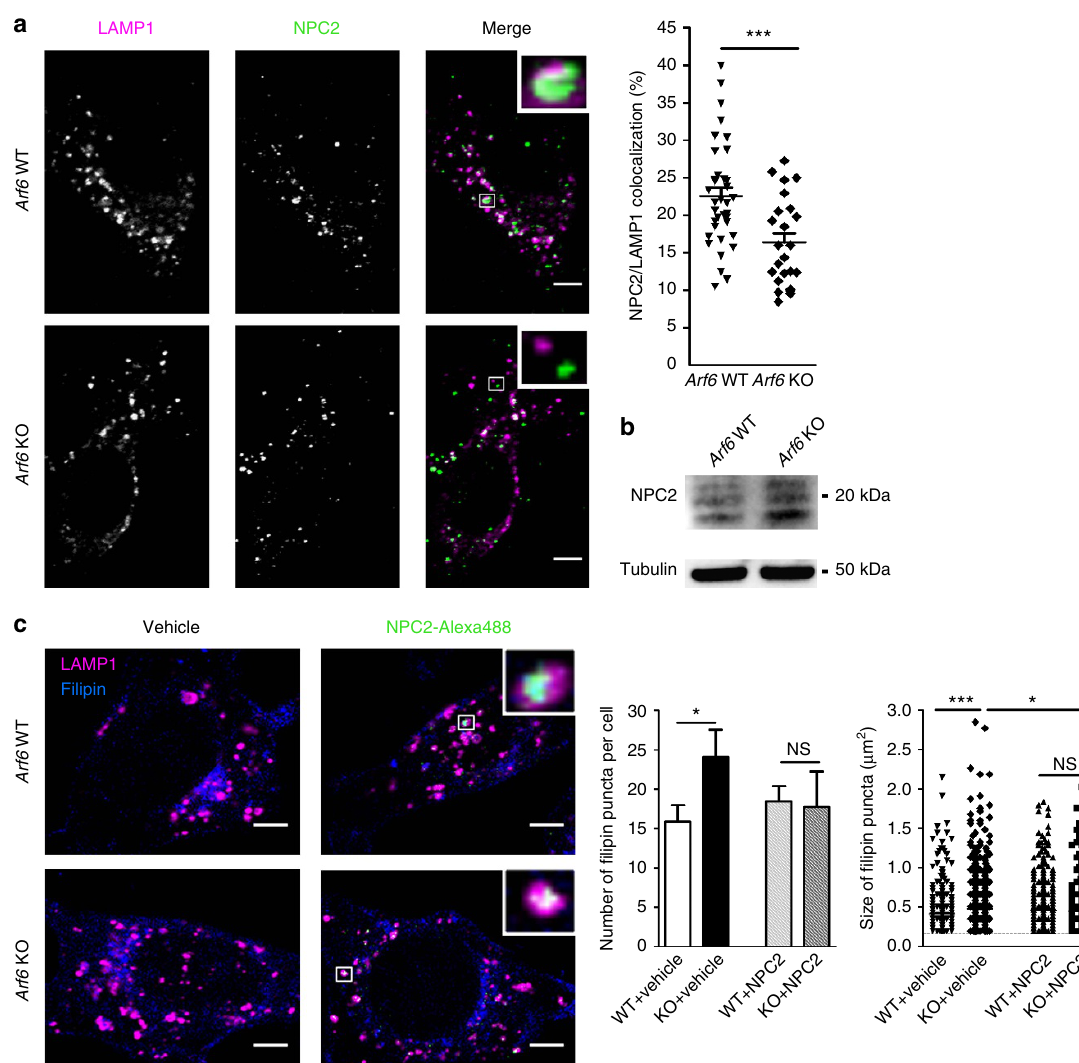
Figure 2 | NPC2 mistrafficking causes cholesterol redistribution in Arf6 KO MEFs. ( a ) Left panel, representative confocal images of Arf6 WTand KO cells immunostained for endogenous LAMP1 (magenta) and NPC2 (green). Scale bar, 5 m m. Right panel, NPC2/LAMP1 co-localization levels in Arf6 WT (23 ± 1%, ± indicates s.e.m., n ¼ 36 cells from three experiments) and Arf6 KO cells (16 ± 1%, n ¼ 24 cells from three experiments). *** P o 0.001 in Student’s t -test. ( b ) Western blot analysis of endogenous NPC2 levels in Arf6 WTand KO cells. Tubulin was used as an equal loading marker. NPC2 protein levels were similar ( P 4 0.05 in Student’s t -test) in Arf6 WT (100 ± 6%, ± indicates s.e.m., n ¼ 3) and KO cells (110 ± 26%, n ¼ 3). ( c ) NPC2-Alexa488 (green) or vehicle was added to the culture media of Arf6 WT and KO cells for 24h. Cells were then washed, fixed and stained for endogenous LAMP1 (magenta) and cholesterol (with filipin, blue). Left panel, representative confocal images. Scale bar, 5 m m. Inset shows that exogenous NPC2 reaches the LAMP1 compartment. Center and right panel, quantification of filipin puncta. Center, number of filipin puncta in vehicle-treated Arf6 WT (16 ± 2 puncta per cell, ± indicates s.e.m., n ¼ 34 cells, three experiments), vehicle-treated KO (24 ± 3 puncta per cell, n ¼ 35 cells, three experiments), NPC2-treated Arf6 WT (18 ± 2 puncta per cell, n ¼ 36 cells, three experiments) and NPC2-treated KO cells (18 ± 5 puncta per cell, n ¼ 28 cells, three experiments). NS and * stand for P 4 0.05 and P o 0.05, respectively, in t -test with Welch’s correction. Right, scatter dot blot of the size of filipin puncta of vehicle-treated Arf6 WT (0.41 ± 0.01 m m 2 , ± indicates s.e.m., 540 puncta from 34 cells), vehicle-treated Arf6 KO (0.48 ± 0.01 m m 2 , 843 puncta from 35 cells), NPC2-treated Arf6 WT (0.46 ± 0.01 m m 2 , 663 puncta from 36 cells) and NPC2-treated Arf6 KO cells (0.45 ± 0.01 m m 2 , 496 puncta from 28 cells). NS denote P 4 0.05, * P o 0.05 and *** P o 0.001 in Mann–Whitney test, respectively. NS, not mistargeting of NPC2 and its thus reduced activity may be puncta in the Arf6 KO cells (Fig. 2c), corroborating our responsible for cholesterol accumulation in LE/LYS. To test this, hypothesis that Arf6 depletion induces cholesterol redistribution we bypassed the anterograde pathway for delivery of NPC2 to to LE/LYS through NPC2 mistrafficking. endosomes by exogenously adding fluorescent NPC2-Alexa488 Mislocalisation of CI-M6PR causes mistrafficking of NPC2 . to MEFs and monitored cholesterol distribution with filipin (Fig. 2c). In vehicle-treated KO cells, cholesterol accumulated in NPC2 trafficking was reported to be dependent on M6PRs, LE/LYS as expected (Fig. 2c). Exogenous NPC2 was able to be with a more significant contribution of CI-M6PR relative to internalized and reach the LAMP1-positive LE/LYS compartment cation-dependent-M6PR (ref. 22). CI-M6PR cycles between the and, remarkably, decreased both the number and size of filipin TGN and endosomes, where it transports its ligands, mostly